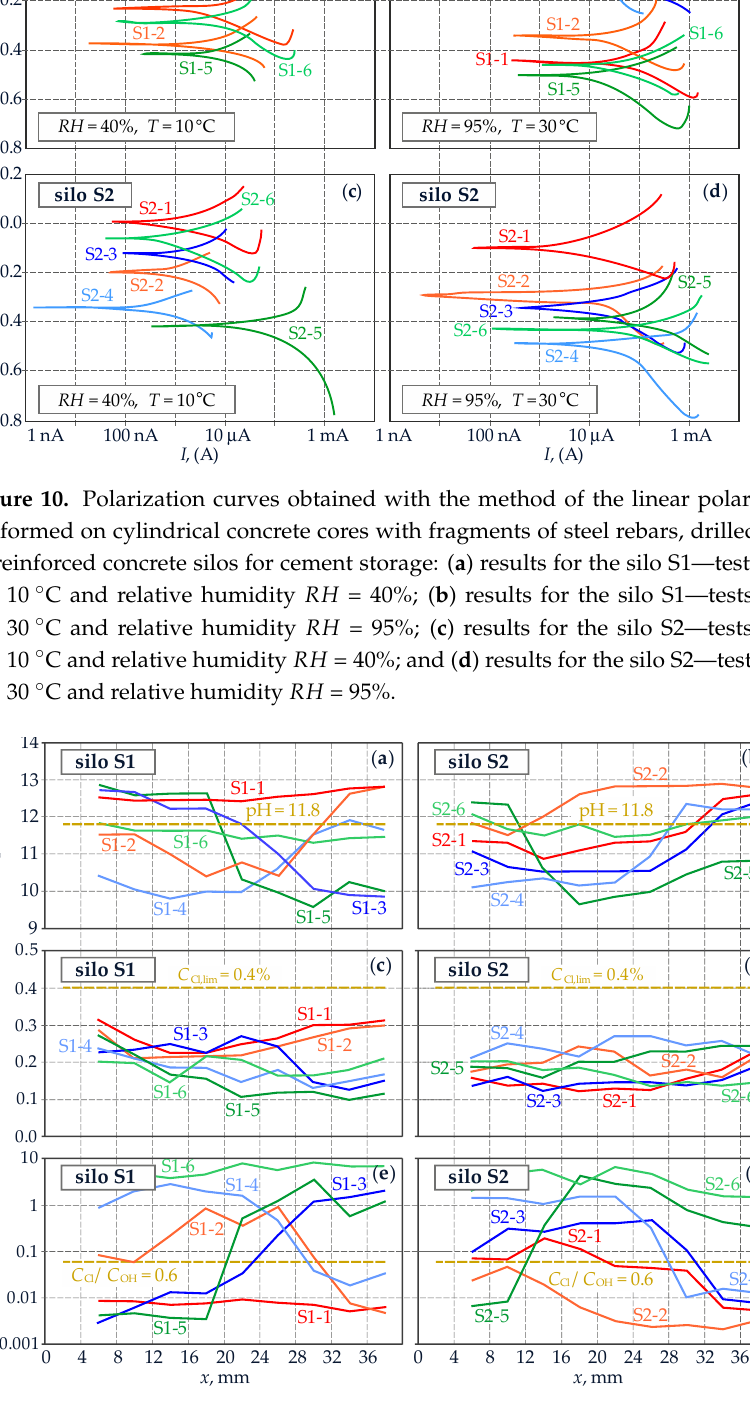
Figure 11. Test results for cores drilled from the silos — protective properties of pore solution against reinforcing steel: ( a , b ) distribution of pH values in the direction x of concrete cover thickness for bars in the silos S1 and S2; ( c , d ) profiles of chloride concentrations in the direction x of concrete cover thickness for bars in the silos S1 and S2; and ( e , f ) distributions in the direction x of concrete cover thickness, values of concentration ratios of chloride and hydroxide ions — the Hausman crite- rion.